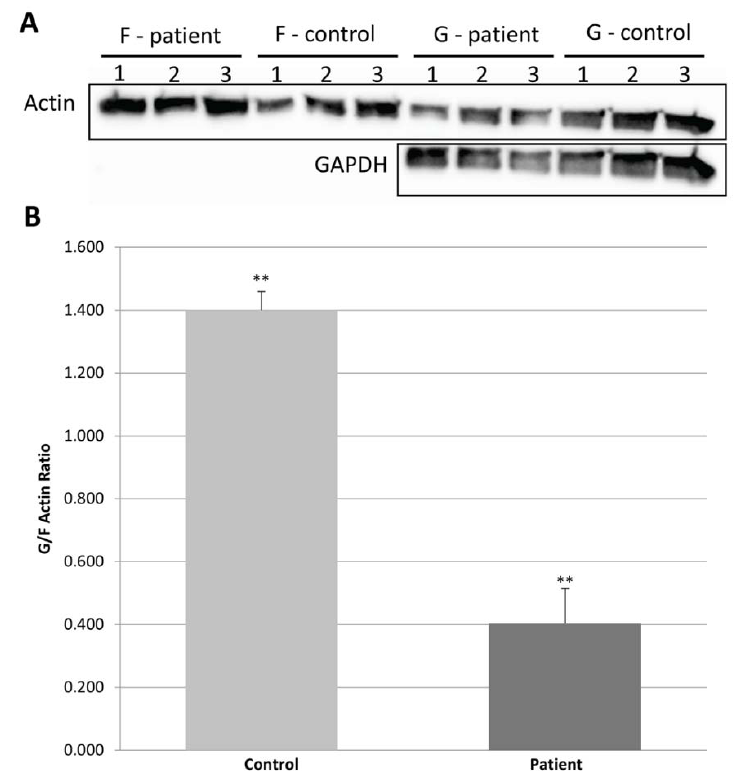
Figure 3. PHACTR2 gene variation significantly decreases the ratio between globular (G) and filamentous (F) actin. ( A ) Representative Western blots showing the G-actin content relative to F-actin in triplicates of patient fibroblast cells compared to control fibroblast cells. GAPDH was used as an internal loading control for the G-actin fraction. ( B ) Western blot results were used to measure the G-actin to F-actin ratio using Fusion software (A2S) while comparing the patient’s fibroblast cells to control fibroblast cells. The results represent three independent experiments; each experiment was verified by triplicate Western analyses. Error bars are SD. ** p ≤ 0.001.